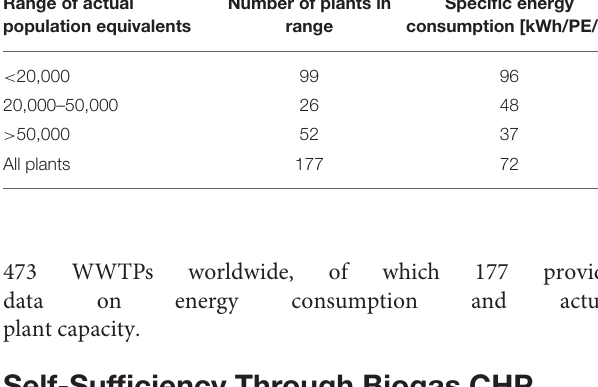
TABLE 1 | Specific energy consumption in dependency of plant capacity in actual population equivalents (ENERWATER, 2018). Range of actual Number of plants in population equivalents